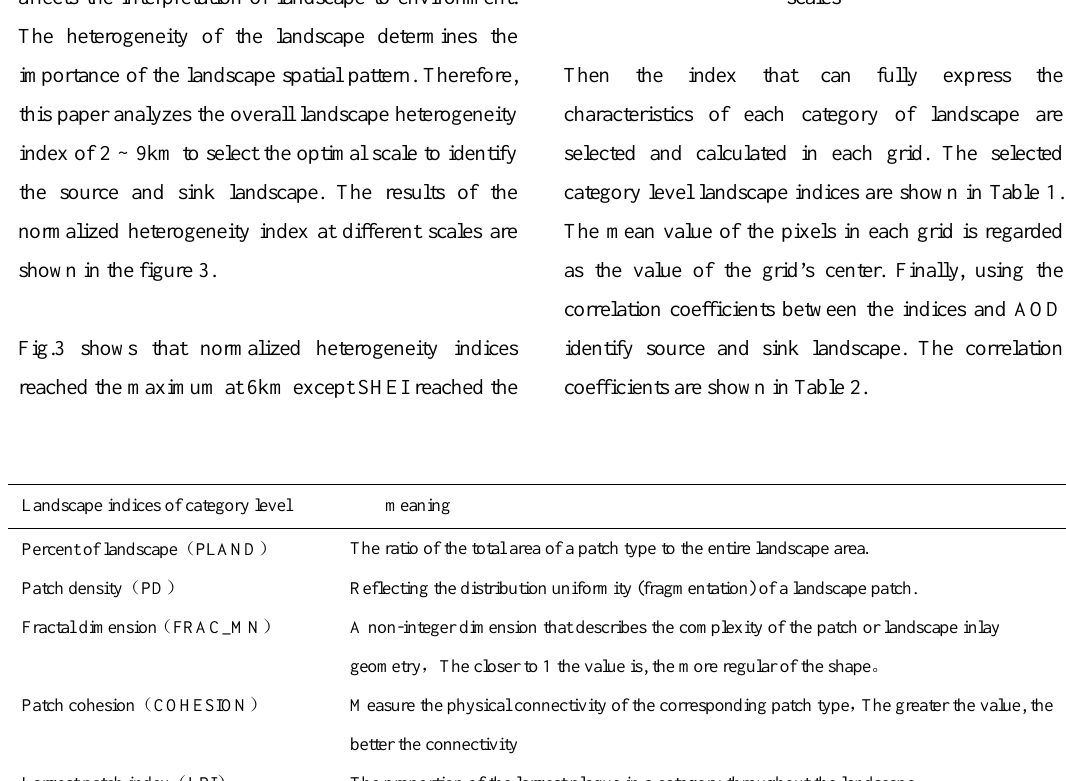
Fig.3 normalized heterogeneity index at different